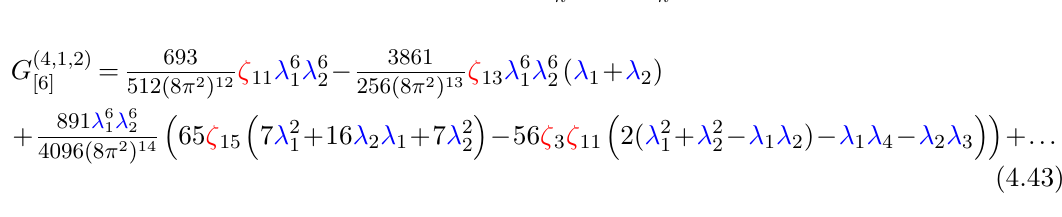
and ¯ O ( d +1) with distance d ~n ~n